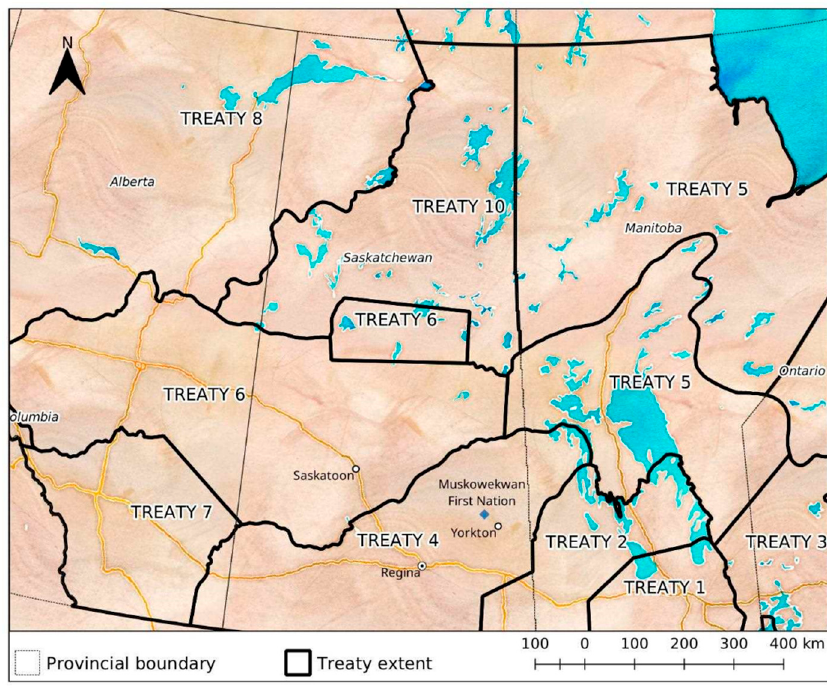
Figure 1. Muskowekwan First Nation, Treaty 4, Saskatchewan.